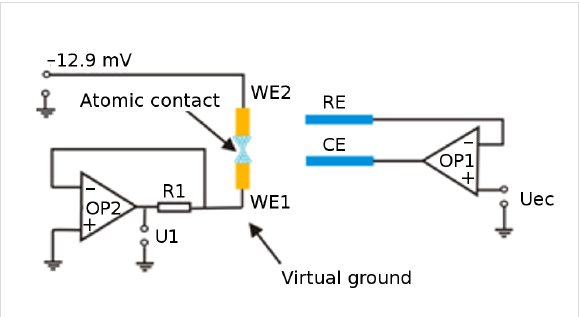
Figure 11: Sketch of the electronic circuit used for the measurements on the electrochemically controlled contacts. The two working elec- trodes (WE1, WE2) are prepared by shadow sputtering on a glass sub- strate. They are about 100 nm thick, and ca. 50 nm apart. The refer- ence (RE) and counter (CE) electrodes are made of highly pure silver wires.